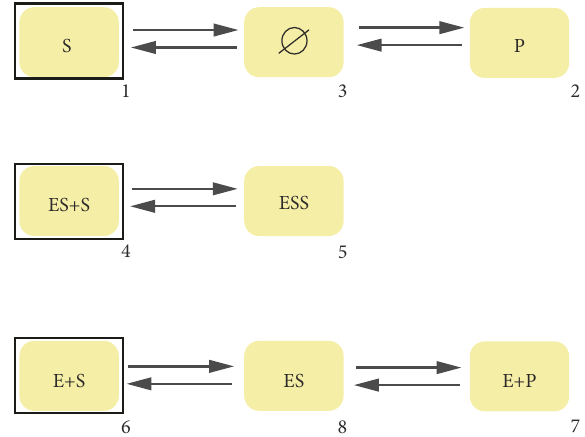
Figure 1: Example 1: a reversible chemical reaction network describing a Michaelis-Menten mechanism. The network involves five chemical species [𝐸,𝑆, 𝐸𝑆, 𝐸𝑆𝑆, 𝑃] , where 𝑆 and 𝑃 represent substrate and product, respectively, transformed under the action of the enzyme 𝐸 via intermediates 𝐸𝑆 and 𝐸𝑆𝑆 . Each maximal set of connectedcomplexes is a linkage class. Following the representation proposed in [28], with each linkage class we associate a reference complex (in squares) that serves to construct the stoichiometric subspace in the first place and will lead to the dynamic structure (1). Assuming mass-action law, we associate with each arrow a chemical reaction coefficient 𝑘 𝑖𝑗 . The zero complex (complex number 3 in the graph) represents the environment which in this case exchanges substrate and product with the